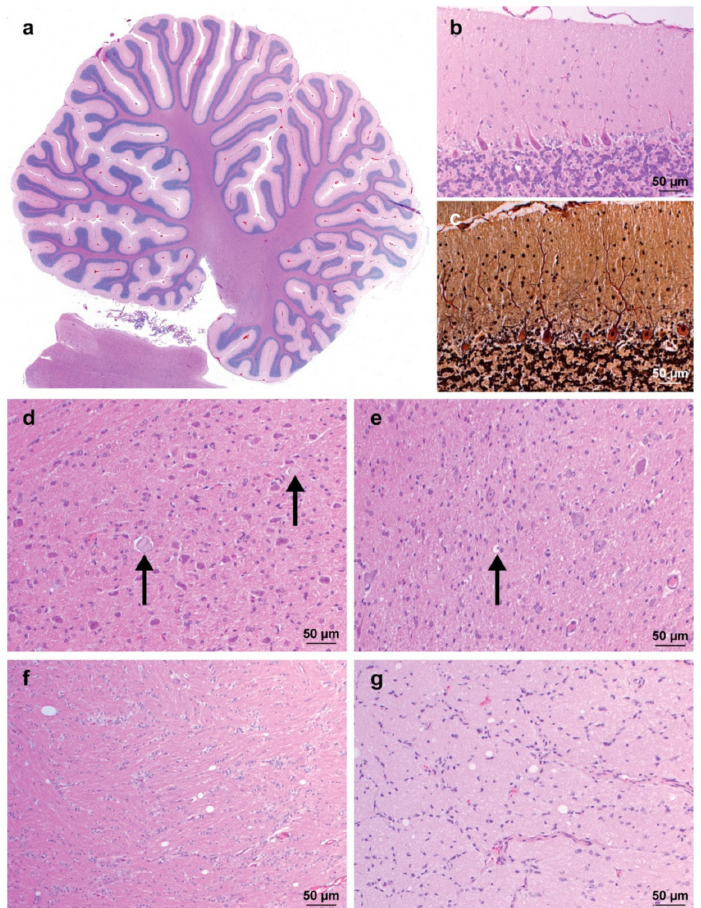
Figure 2. Neuropathology of a spinocerebellar ataxia-a ff ected Alpine Dachsbracke dog. ( a ) Overview of the cerebellum showing a normal architecture. HE staining; ( b ) Cerebellar cortex with normal Purkinje cell layer. The molecular layer exhibits a slightly increased cellularity due to mild astrogliosis. Astrocytes have rather open-faced nuclei. Note the single, clearly delineated empty vacuole in the granule cell layer. Hematoxylin and eosin (HE) staining; ( c ) Cerebellar cortex with normal Purkinje cell layer. No empty baskets are observed. Bielschowsky stain; ( d ) Vestibulocochlear nucleus with marked astrogliosis and two axonal spheroids (arrows). HE staining; ( e ) Cerebellar nucleus showing marked astrogliosis and a single dilated myelin sheath with a central myelinophage (arrow). HE staining; ( f ) Corona radiata exhibiting di ff use astrogliosis and multiple clearly delineated empty vacuoles. HE staining; ( g ) Optic chiasm with multiple clearly delineated empty vacuoles. HE